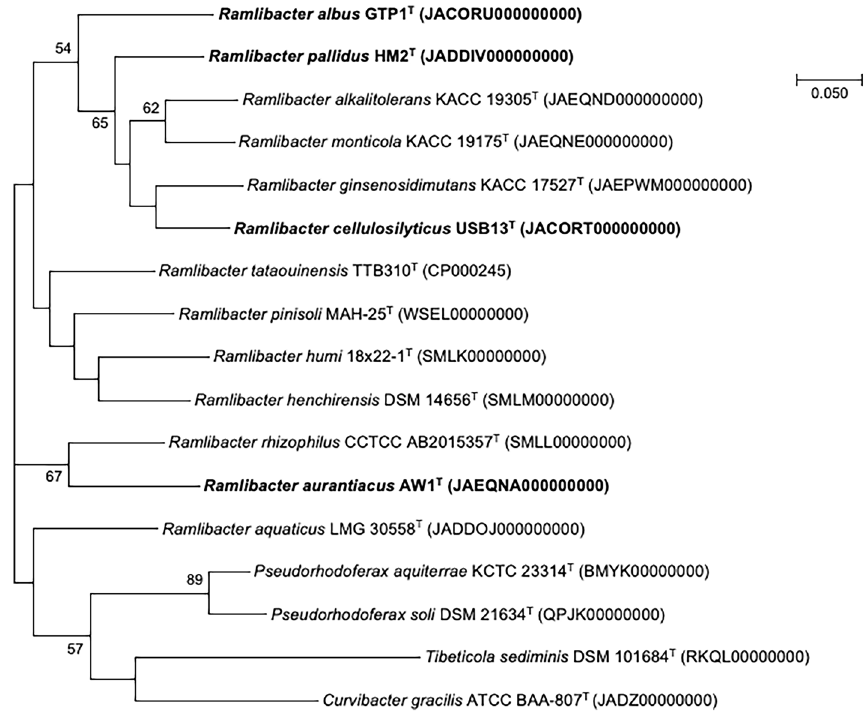
Figure 2. Phylogenomic tree of strains USB13 T , AW1 T , GTP1 T , and HM2 T and their closely related taxa was reconstructed based on core genomes using UBCG version 3.0 pipeline 42 . NCBI GenBank accession numbers are shown in parentheses. Bootstrap analysis was carried out using 1000 replications. Percentage bootstrap values (> 50%) are given at branching points. Bar, 0.050 substitution per